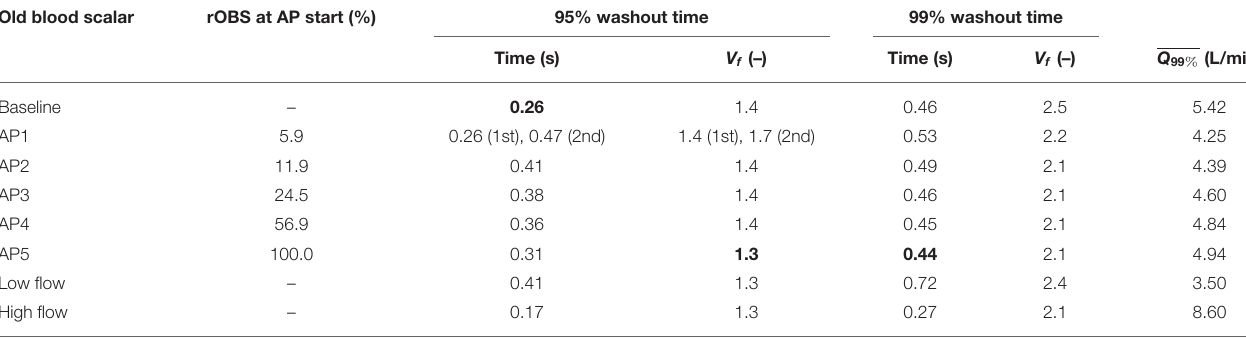
TABLE 1 | 95 and 99% washout times for different old blood scalars considered in the